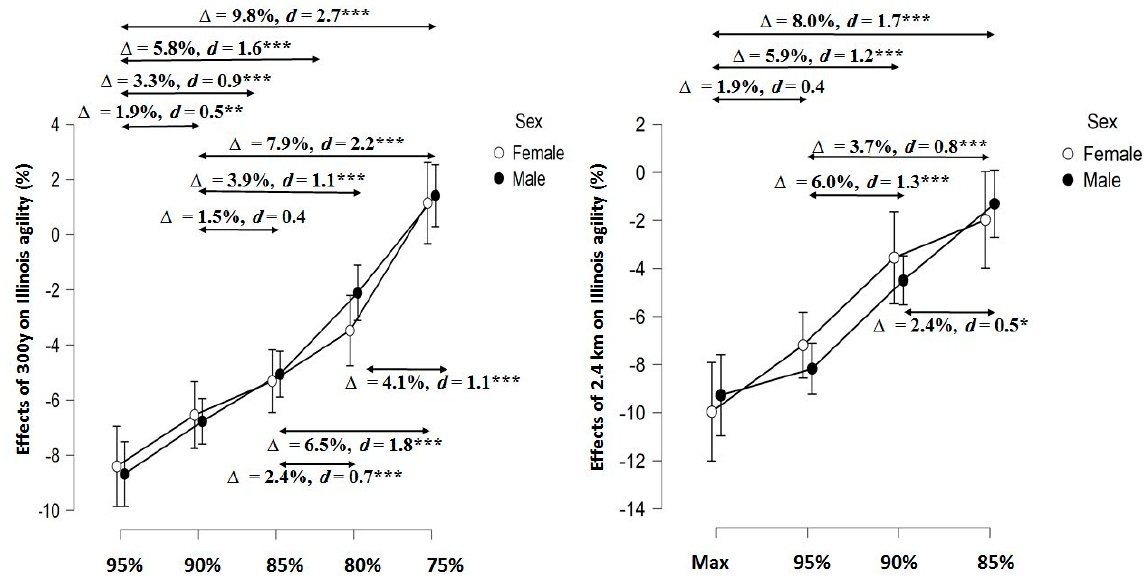
Figure 2. Effects of different running intensities on the Illinois Agility Test. * Significant at p < 0.05, ** Significant at p < 0.01, and *** Significant at p < 0.001, d—Cohen’s effect size, ∆ —relative difference between effects obtained after two different running intensities. Max, 95%, 90%, 85%, 80%, 75%— running intensities of SR300y and CT2.4km.